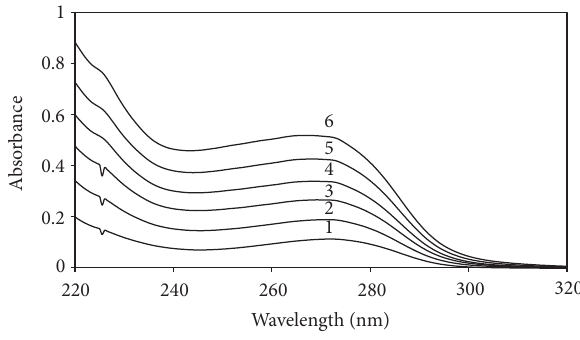
F 2: e spectra of the ternary mixture aer addition of standards ASP, CAF, and PAR in the same mole ratios in the concentration range of 10–60